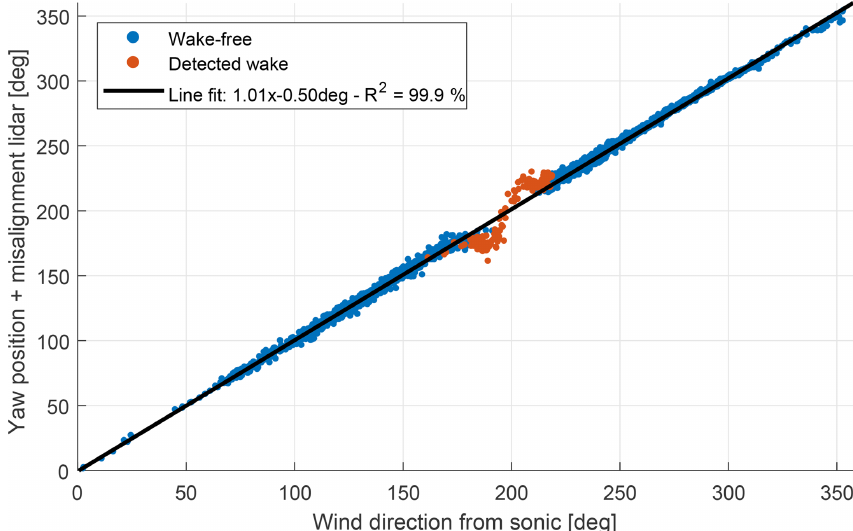
Figure 10. 10min mean wind direction correlation between the meteorological mast sonic anemometer and the wind direction estimate from the lidar, i.e. lidar misalignment + yaw position of the turbine. Outside the wake sector a high degree of similarity can be observed. The identified wake situations lead to a bias. The line fit is performed on wake-free data only.